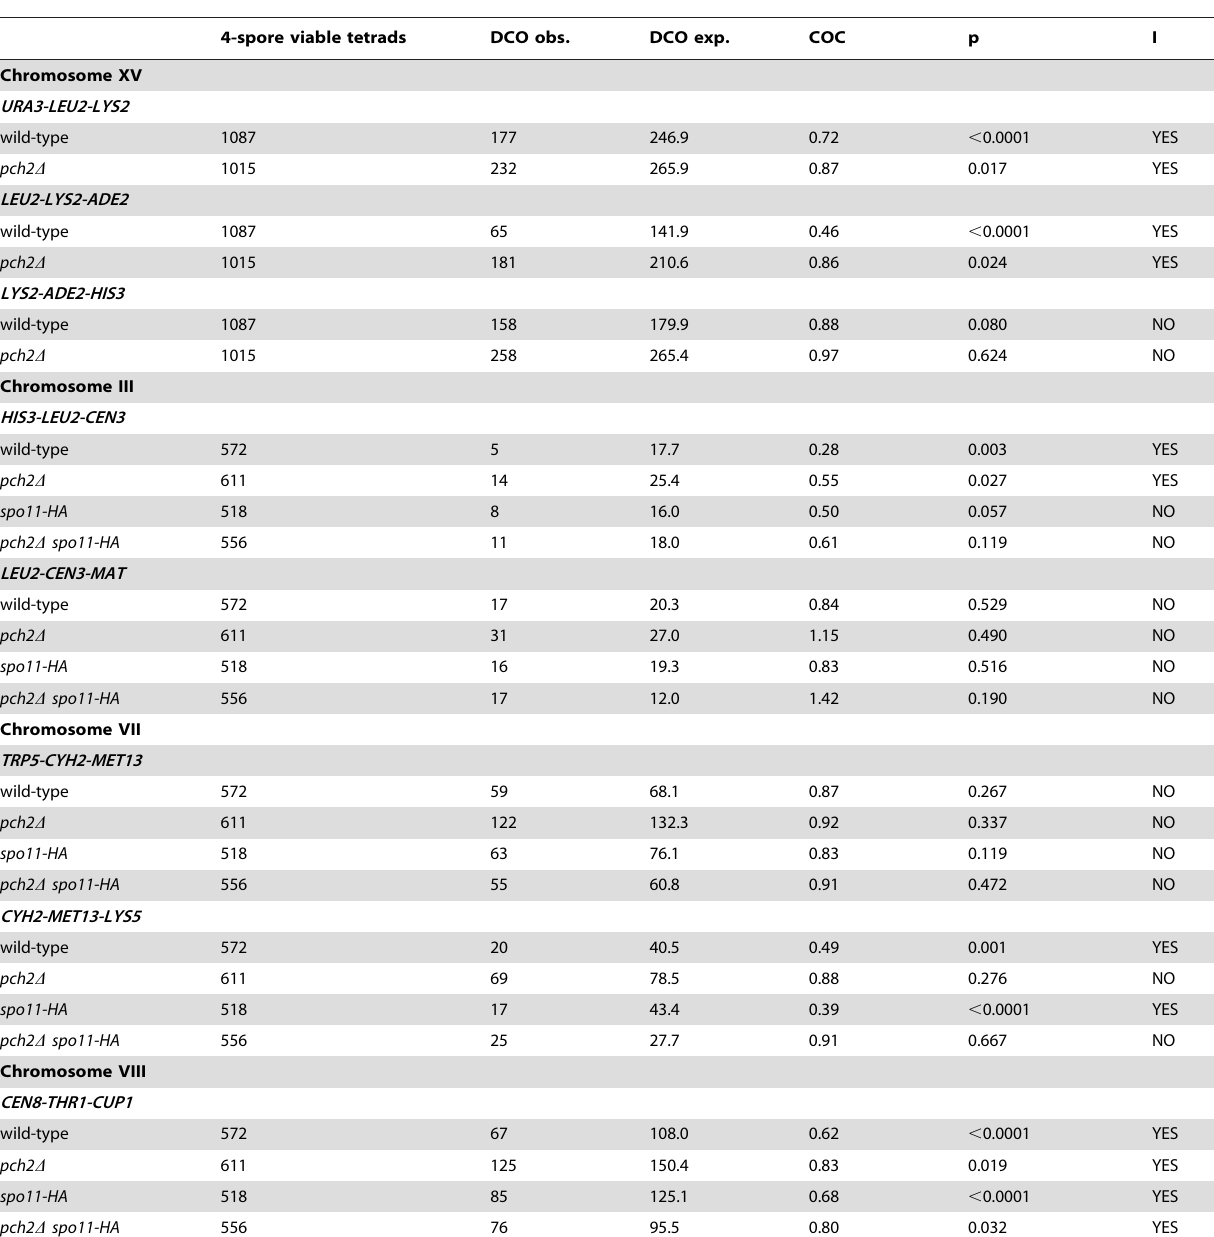
Table 5. Interference calculations using coefficients of coincidence.